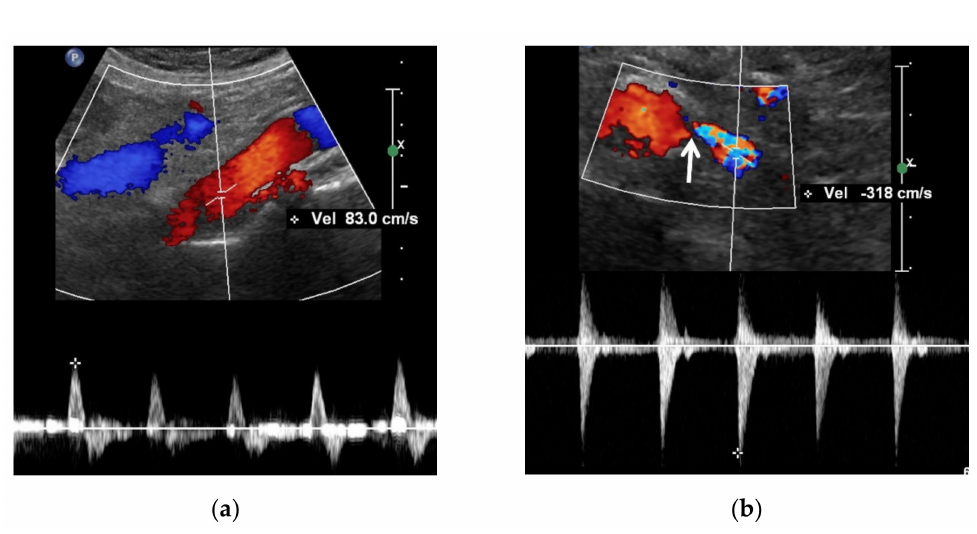
Table 4. Imaging features of renal artery stenosis on Doppler US. Doppler US Renal Artery US Renal US Color Doppler US Bright blue or red Normal/weak/no perfusion Turbulent signal Spectral Doppler US PSV (>180–200 cm/s) Pulsus tardus and parvus Reno-aortic PSV ratio (>3.5) Delayed acceleration Turbulent spectrum Low resistive index Note: PSV, peak systolic velocity.